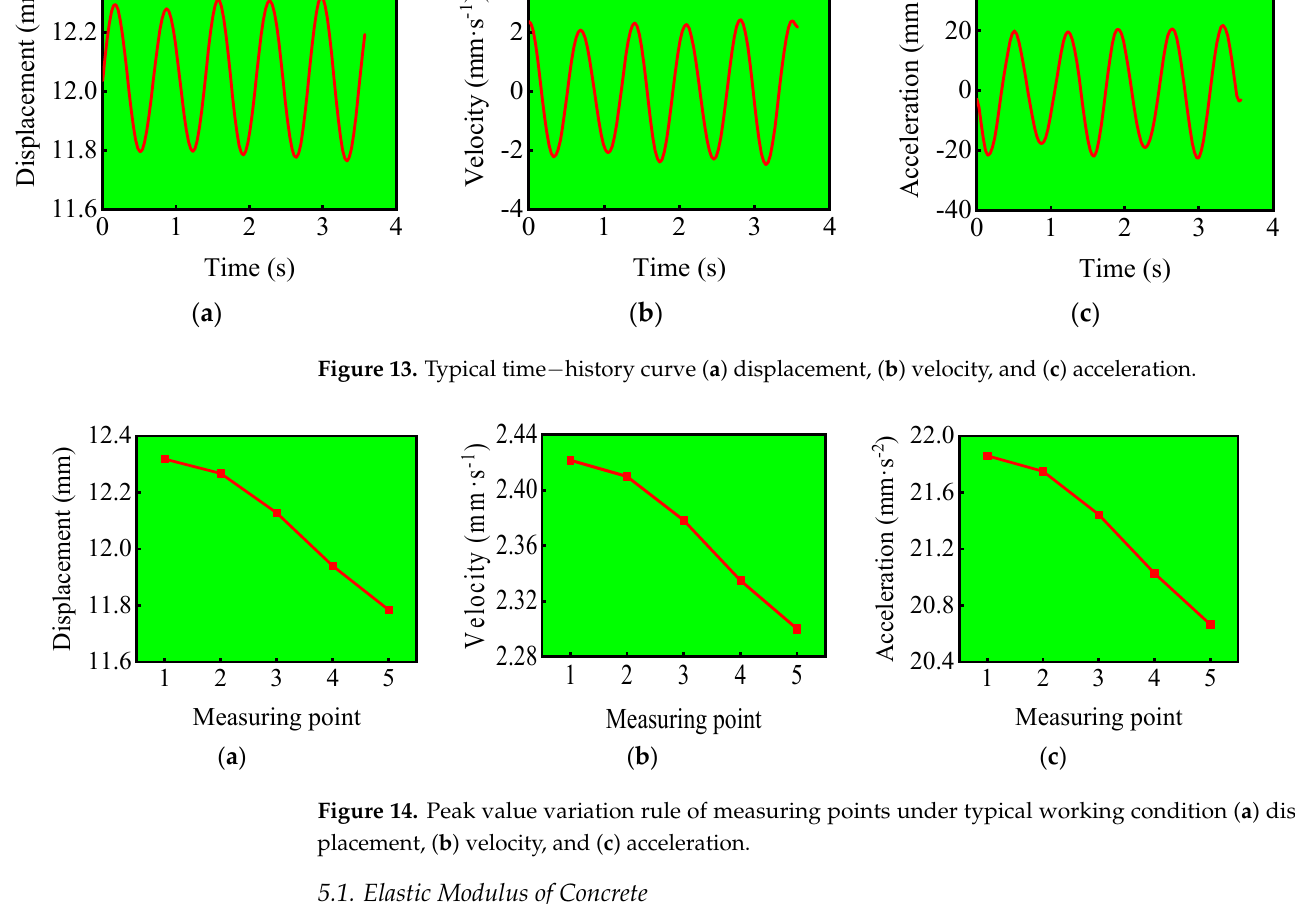
Table 3. Results of peak displacement, velocity, and acceleration at the mid − span measuring point when the elastic modulus of concrete changes.